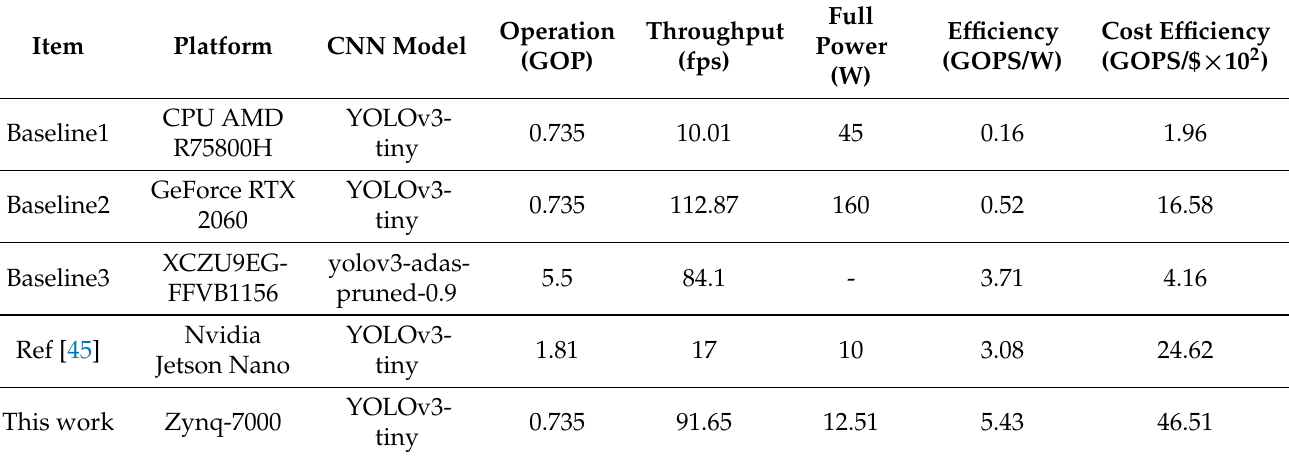
Table 7. Cross-platform